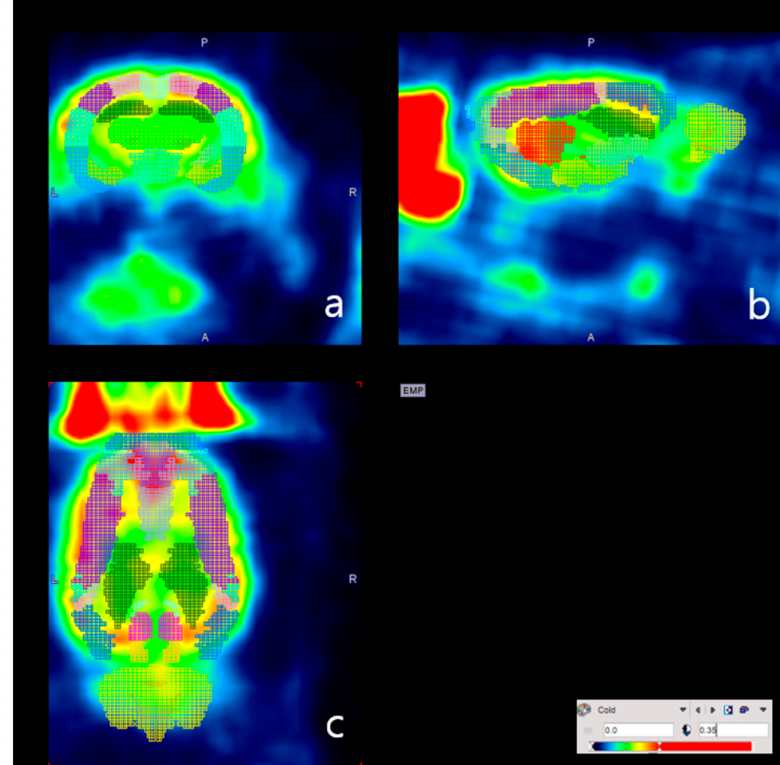
Figure 2. Quantification of FDG brain uptake of each cerebral region. Representative images- co-registered PET atlas images for one subject-are shown in the ( a ) coronal, ( b ) sagittal, and ( c ) axial